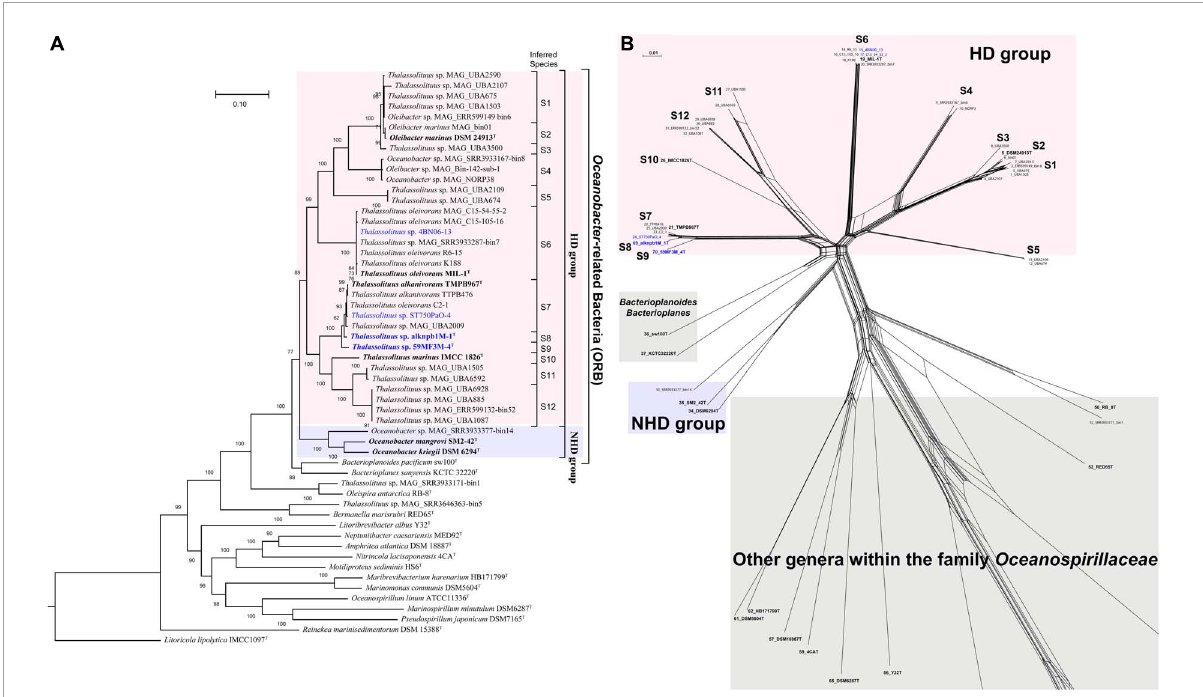
FIGURE2 Phylogenetic relationships of the Oceanobacter -related type or representative strains and metagenome-assembled genomes (MAGs) along with the type strains within the family Oceanospirillaceae . (A) The maximum-likelihood phylogenomic tree was constructed using the concatenation of 120 ubiquitous bacterial single-copy proteins identified by GTDB-Tk (v. 1.5.0). The inferred taxonomies of all genomes are shown in Supplementary Table 2 . Bootstrap values converted to a percentile scale were based on 1,000 replicates. Only bootstraps exceeding 50% are shown. Genomes retrieved from the strains isolated in this study and the type strains of ORB are highlighted in blue and black bold, respectively. Genomes retrieved from the metagenome-assembled genomes are marked by "MAG" in their names. The type strain Litoricola lipolytica IMCC1097 T was used as the outgroup. (B) Phylogenetic network of Oceanobacter -related bacteria reconstructed by SplitsTree (v. 4.18.3) using the neighbor-net algorithm. The network was based on the concatenated sequences of five housekeeping genes, including gyrB (gyrase B subunit), polA (DNA polymerase I), icd (isocitrate dehydrogenase), pryH (uridylate kinase), and mdh (malate